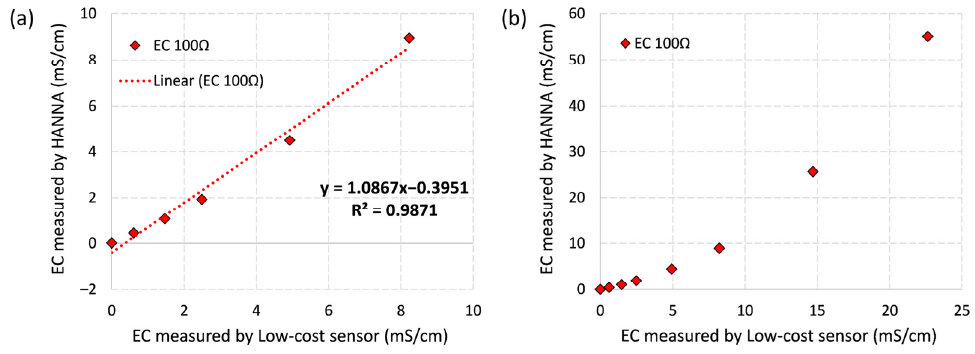
Figure 10. ( a ) correlation between the low-cost conductivity sensor and HANNA’s measurement results in standard EC solutions ranging from 0 to10 mS/cm; and ( b ) correlation in solutions between 0 and 60 mS/cm.